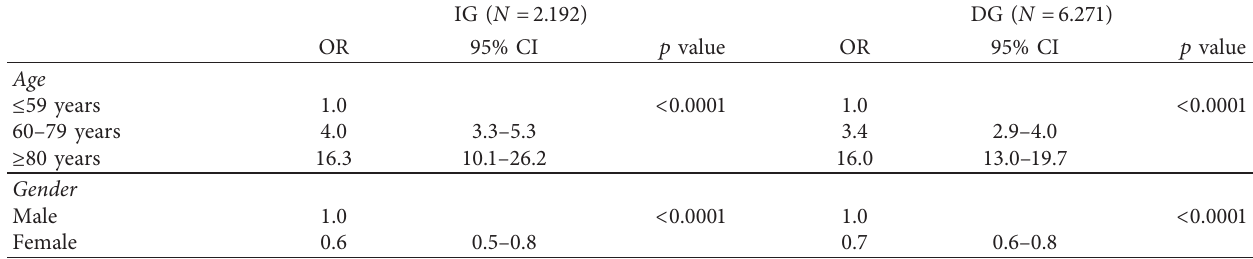
Table 1: Multivariable logistic analysis of edentulous patients treated with implants (IG � 2.192 patients) or not (DG � 6.271 patients).